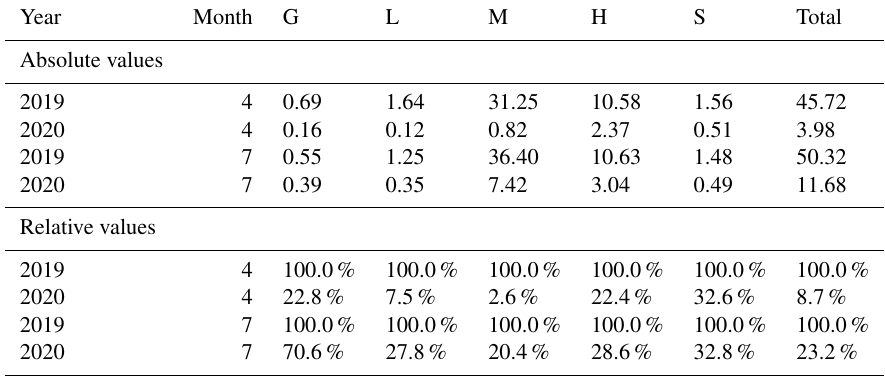
Table 1. Flight distances (in Gm) of general aviation and military jets (G: MTOM < 20Mg), light (L: 20 < MTOM < = 46Mg), medium (M: 46 < MTOM/Mg < = 115), heavy (H: 126 < MTOM/Mg < = 395Mg), and super heavy (S: 395 < MTOM/Mg) aircraft over Europe above